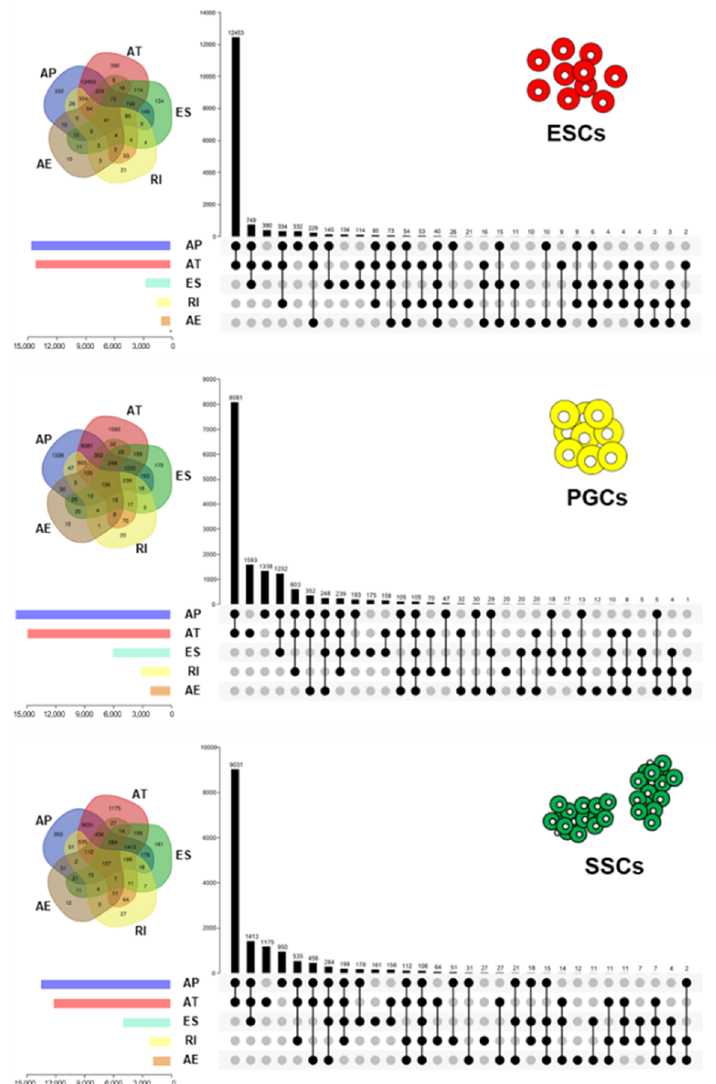
Figure 2. Distribution analysis of AS events during male chicken germ cell differentiation. The Veen and Upset plots show the distribution of AS events in chicken ESCs, gPGCs, and SSCs. The bar chart above represents the number of genes contained in each type of group. The bar chart at the bottom-left represents the number of events included in each type of AS event. The dotted line at the bottom-right shows the types of events contained in the group.